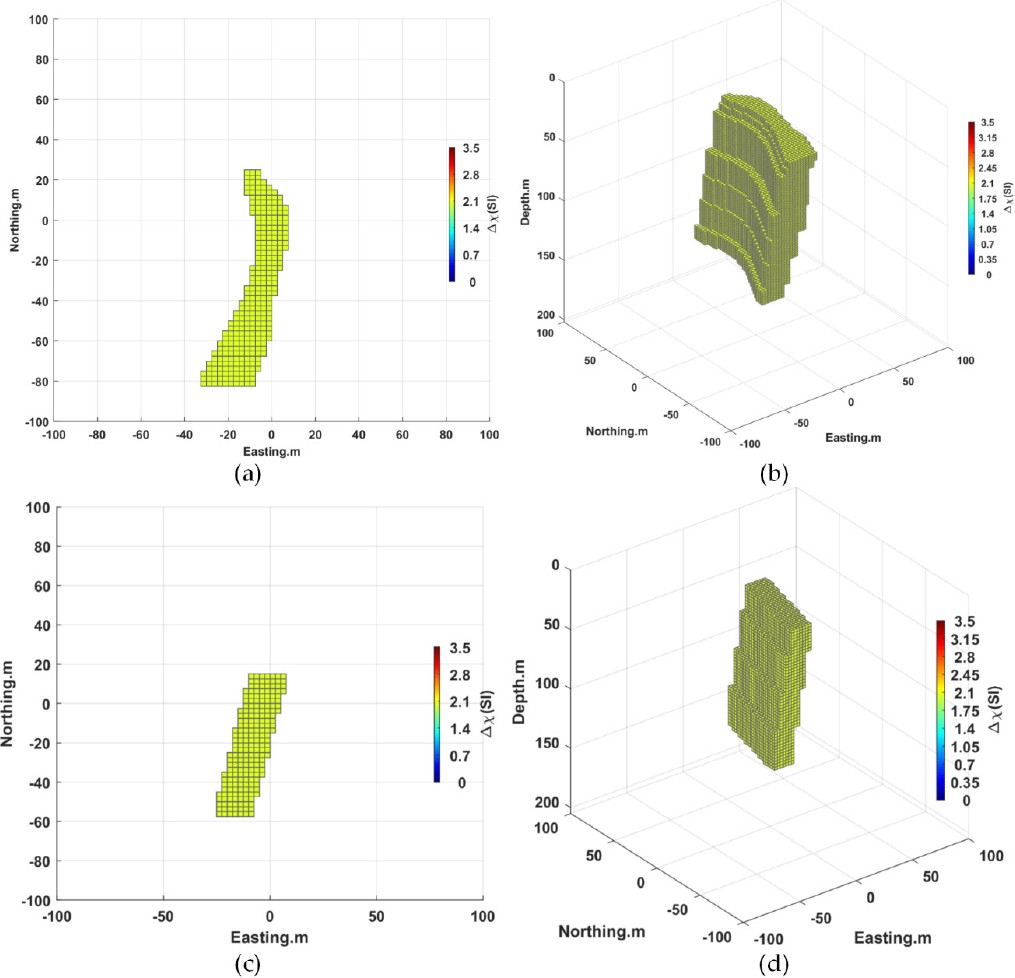
Figure 17. Example models. ( a ) Planar graph of an arc tilted magnetic vein, ( b ) section view of an arc tilted magnetic vein, ( c ) planar graph of a rhomboidal tilted magnetic vein, and ( d ) section view of a rhomboidal tilted magnetic vein.